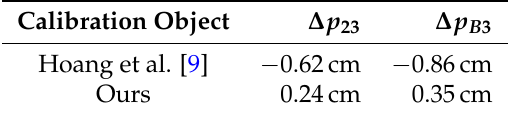
Table 3. Error of distance p 23 (median) and the resulting error of p B 3